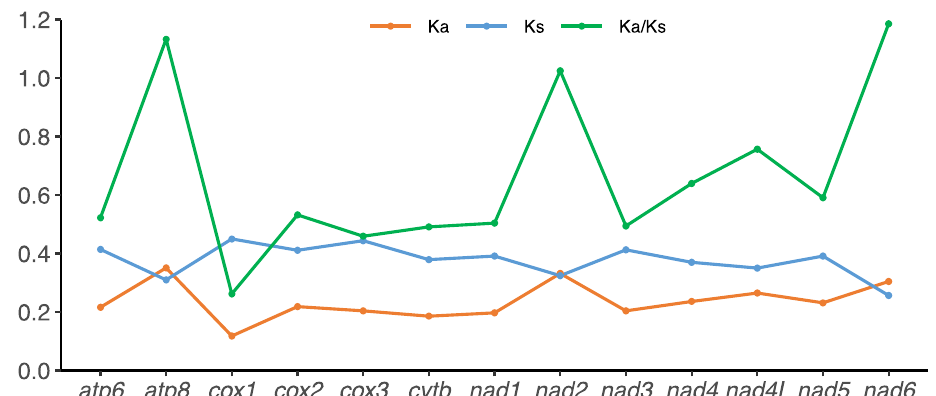
Figure 3. Non-synonymous (Ka), synonymous substitutional (Ks) rates and the ratios of Ka/Ks of 13 protein coding genes (PCGs) in mitochondrial genomes of all sequenced species in